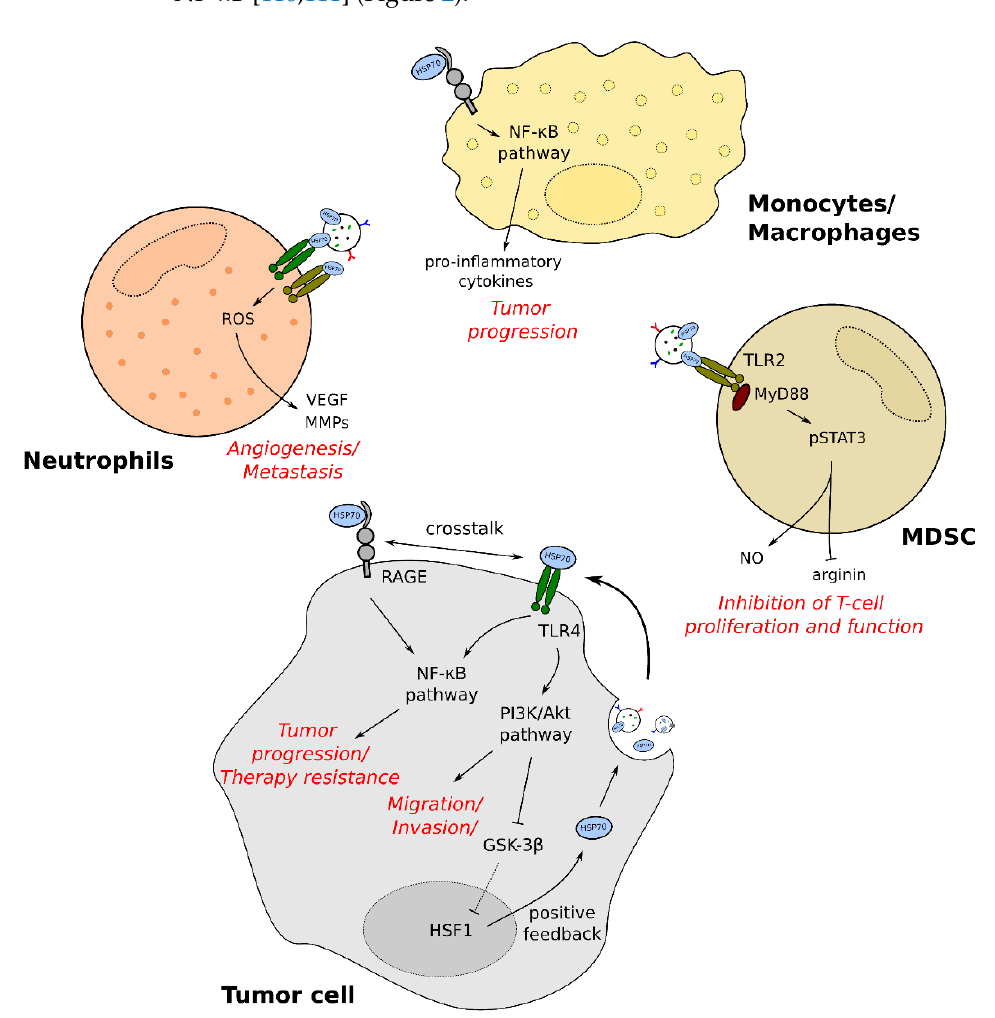
Figure 2. Pro-tumorigenic functions of exHSP70. MDSC: myeloid-derived suppressor cell; RAGE: receptor for advanced glycosylation endproducts; GSK-3 β : glycogen synthase kinase-3 β ; NO: nitride oxide; TLR: Toll-like receptor; NF κ B: nuclear factor kappa-light-chain-enhancer of activated B cells; HSF1: heat shock factor 1; VEGF: vasculogenic endothelial growth factor; pSTAT3: phosphorylated signal transducer and activator of transcription 3; ROS: reactive oxygen species; MyD88: myeloid differentiation primary response 88; PI3K: phosphoinositide 3-kinase; Akt: protein kinase B; MMP: matrix metalloproteinases; HSP70: heat shock protein 70 .